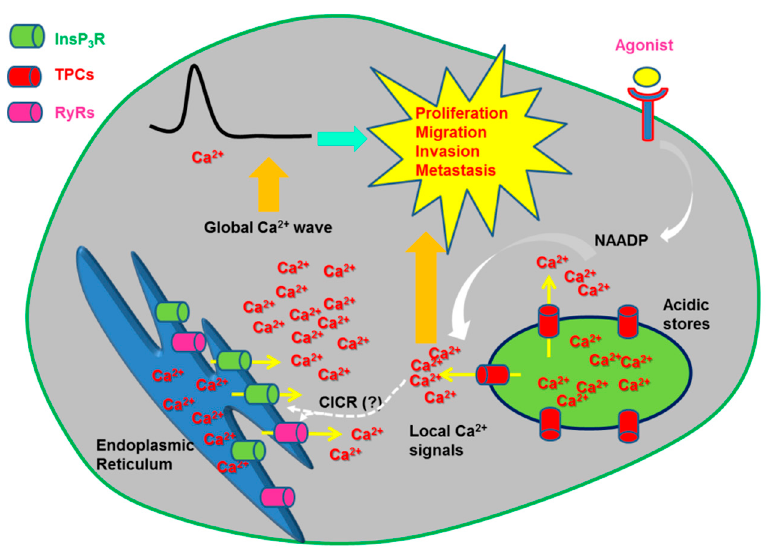
Figure 4. TPCs mediate oncogenic Ca 2+ signals. Emerging evidence indicates that NAADP promotes tumorigenesis by inducing EL Ca 2+ release through TPCs. Work carried out on melanoma B16 cells suggest that NAADP is synthesized in response to VEGF stimulation. NAADP-induced Ca 2+ signals promote tumorigenesis by stimulating migration, invasion, angiogenesis and, maybe, proliferation.